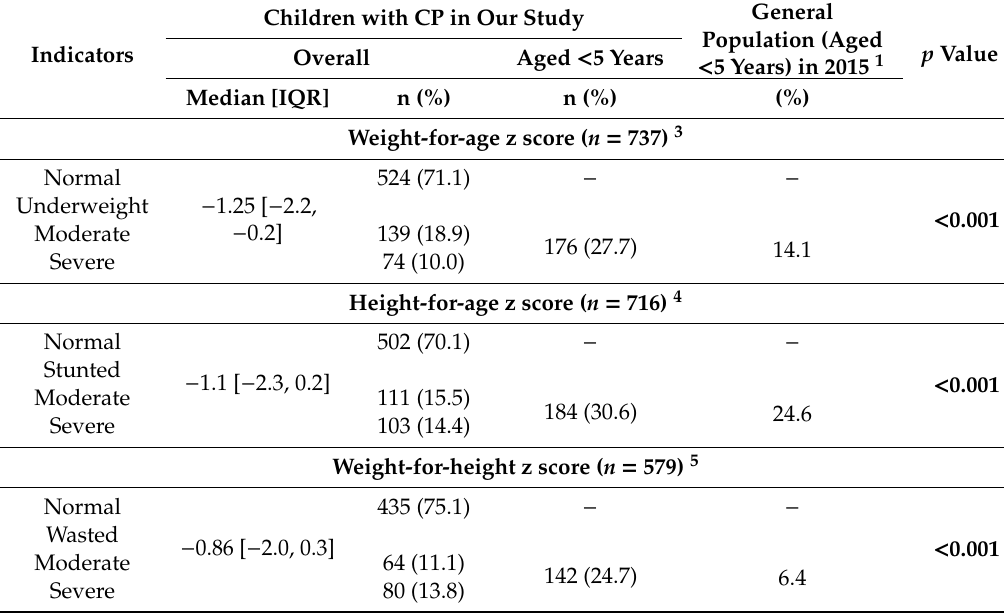
Table 1. Nutritional status of the study